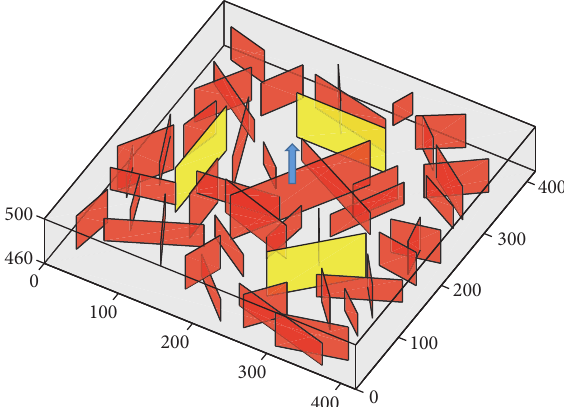
Figure 17: Configuration of the fractured reservoir.